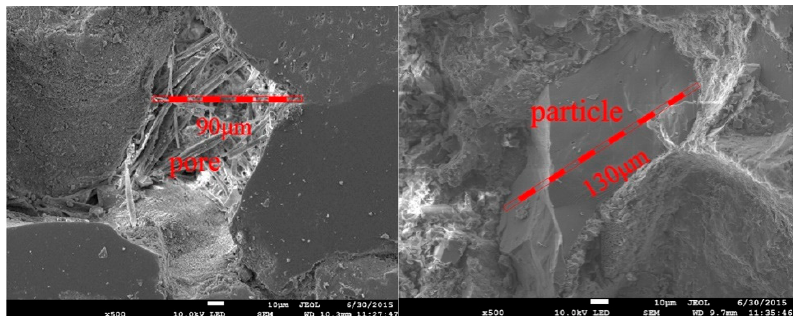
Figure 3. Scanning electron microscope (SEM) images of the sandstone.